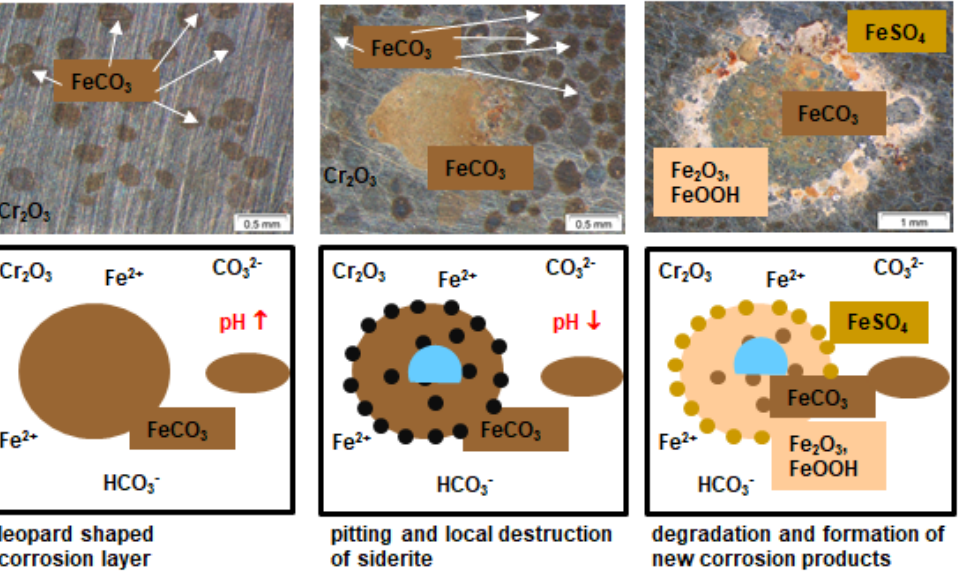
Figure 12. Schematic illustration of the degradation of the passivating siderite corrosion layer formed on 16–17% Cr high alloyed stainless steels X35CrMo17 and X5CrNi CuNb16-4.